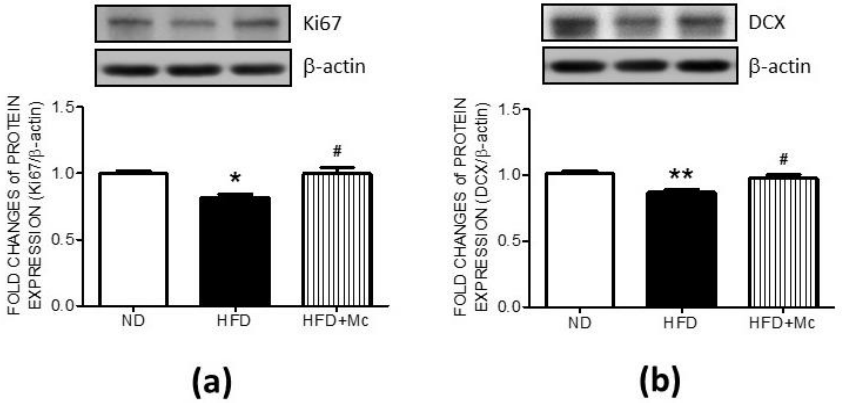
Figure 4. Inhibition of HDAC4 by Mc1568 interfered with the suppression of both Ki67 and DCX expression in the hippocampus of the HFD group. The representative gel and densitometric analyses of ( a ) Ki67, and ( b ) DCX in female offspring hippocampi at 12 weeks old. *p < 0.05, **p < 0.01 indicate significant differences from the ND group and # p < 0.05 indicate significant differences from the HFD group using a post-hoc Tukey’s multiple range test. ND: n = 12; HFD: n = 12; HFD + Mc: n = 6. ND: female offspring exposed to a maternal normal diet; HFD: female offspring exposed to a maternal high-fructose diet; Mc-1568 (Mc), 5 µ M by icv infusion for 4 weeks. β -actin was used as an internal loading control.